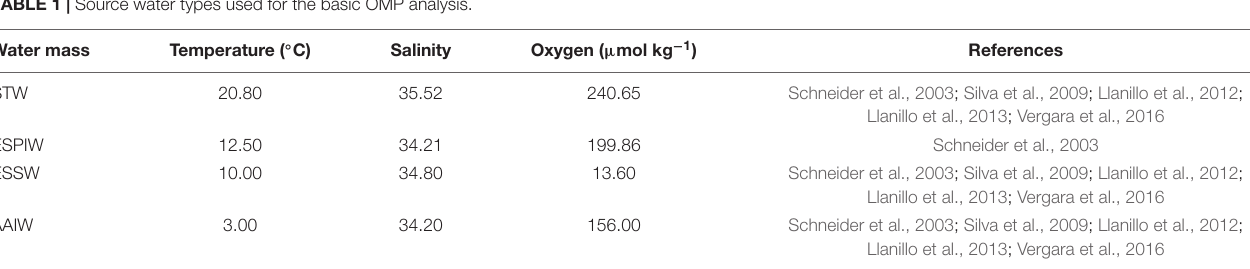
FIGURE 1 | (A) Study area illustrating the stations for oceanographic data and zooplankton samples in the cruise CIMAR21 during October–November 2015 in the Pacific Southeast of Chile ( ∼ 27 ◦ S). (B) Monthly satellite-derived total Chlorophyll-a (mg m − 3 ). (C) Sea level anomaly (cm) and the geostrophic velocity field. TABLE 1 | Source water types used for the basic OMP